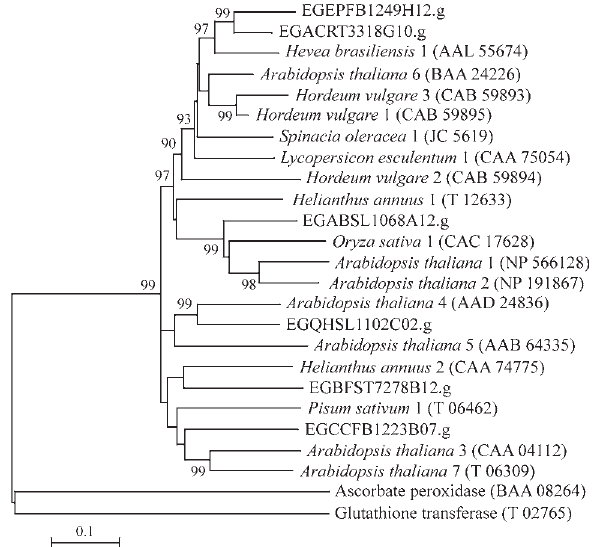
Figure 8 - Phylogenetic tree of PhGPx proteins. Phylogenetic analyses were conducted as described in Figure